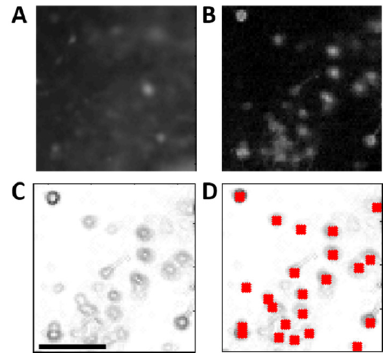
Figure 5. Automated image processing for locating cell somata. ( A ) A raw single post-stimulus frame (512 × 512 pixels) is displayed from a series of frames (30 fps); ( B ) Image subtraction is performed to highlight the fluorescence difference post-stimulus from pre-stimulus; ( C ) The background is subtracted, and a gradient of the difference image is used to highlight the somata boundaries; ( D ) A circular Hough filter is applied to the gradient image to locate neuronal somata. Grid of 16 × 16 pixels (shown with red squares) mark the soma centers. Scale bar: 100 μ m.